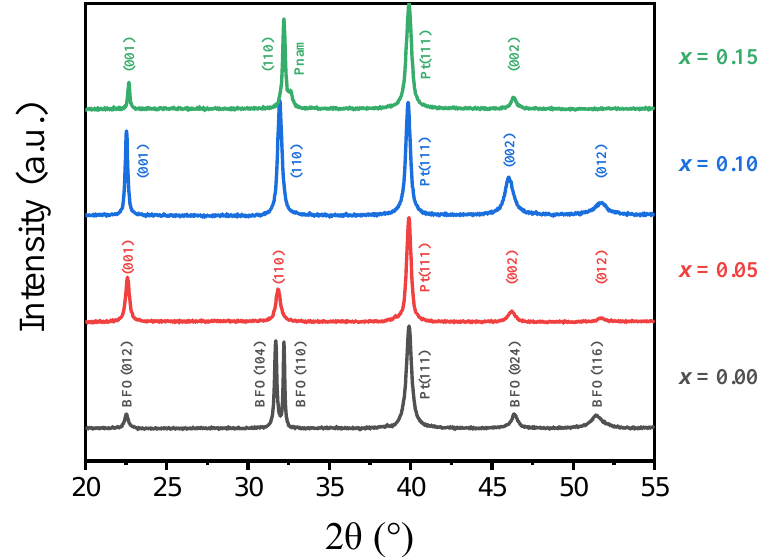
Figure 1. XRD patterns of Bi 1− x Gd x FeO 3 ( x = 0.00, 0.05, 0.10, and 0.15) films. TEM images of Bi 1 − x Gd x FeO 3 with x = 0.00, 0.05, 0.10, and 0.15 are shown in Figure 2a–d. The average grain size, estimated through Image J software, is refined from